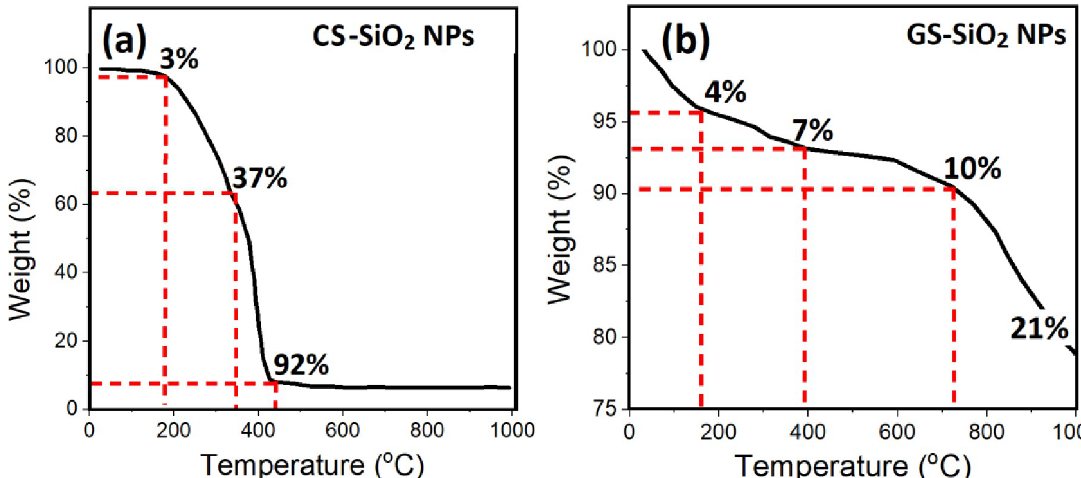
Fig 11. TGA analysis for (a) CS-SiO 2 NPs and (b) GS-SiO 2 NPs.